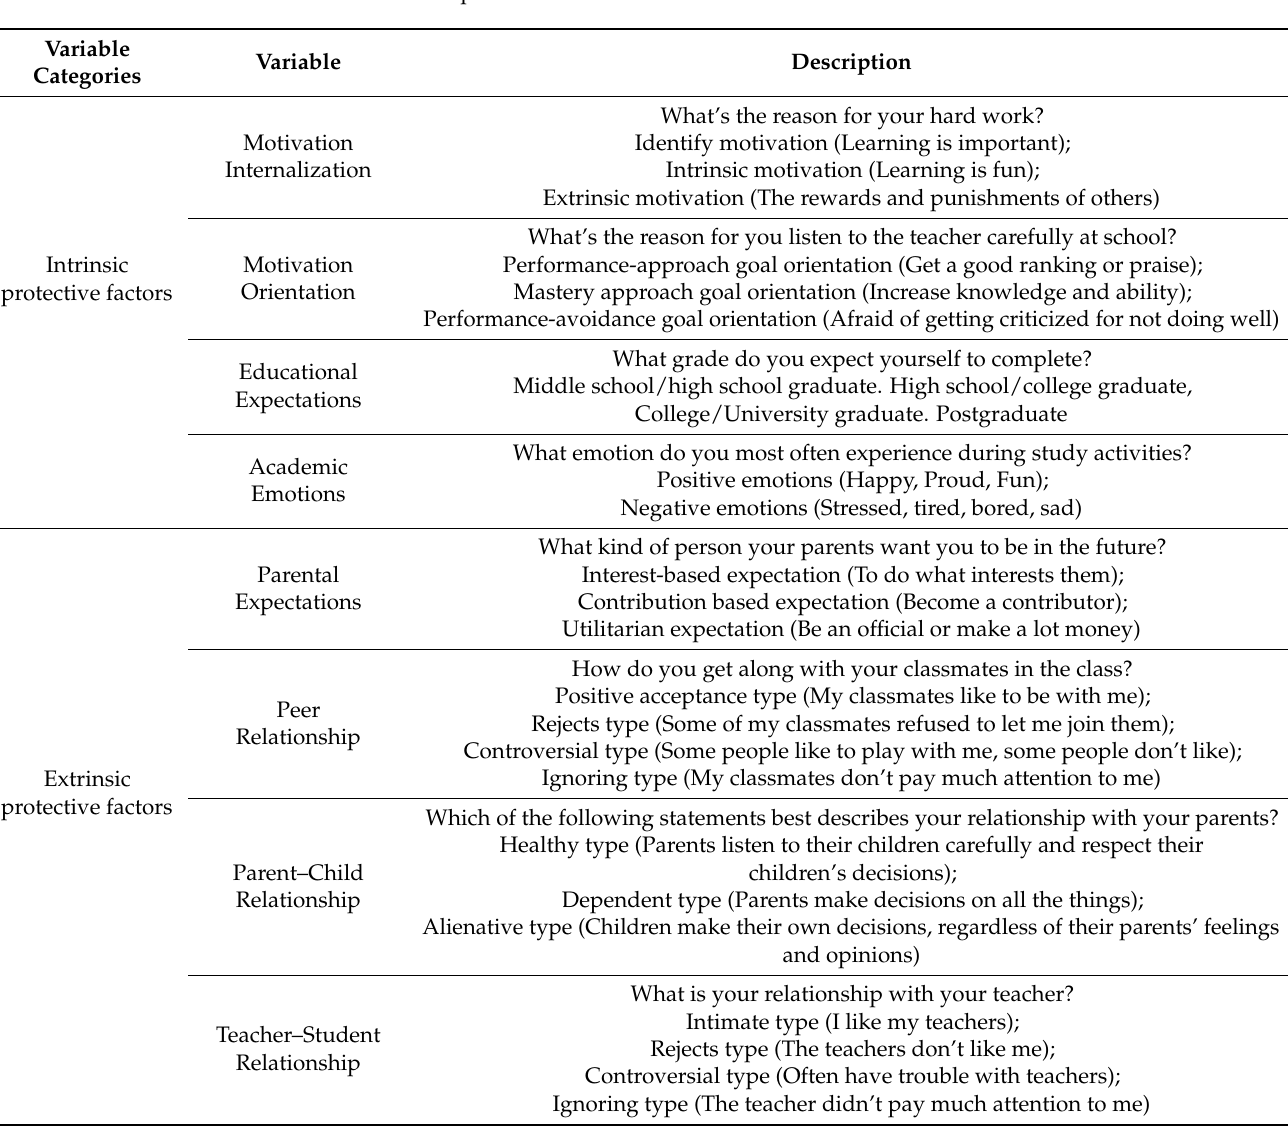
Table 2. Description of variables.